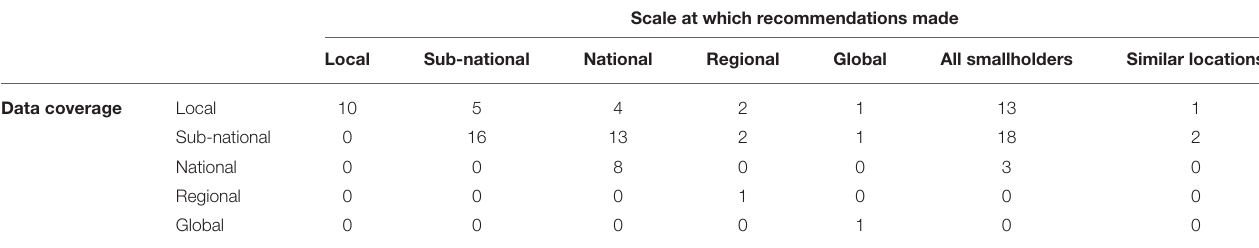
TABLE 7 | A cross tabulation of the coverage of the data used in the article, compared to the scale of recommendations made in the articles reviewed.